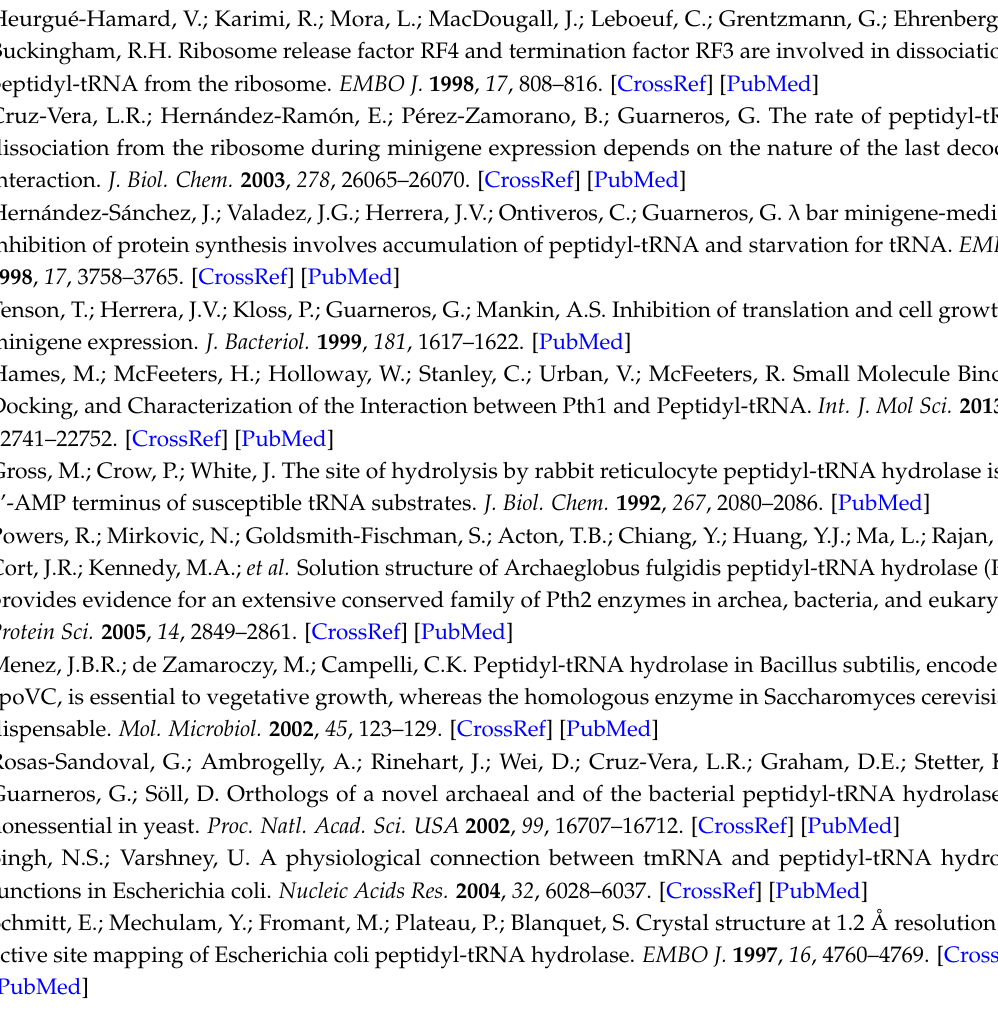
Figure S1: Pth1 Amino Acid Sequence Conservation, Figure S2: Compound